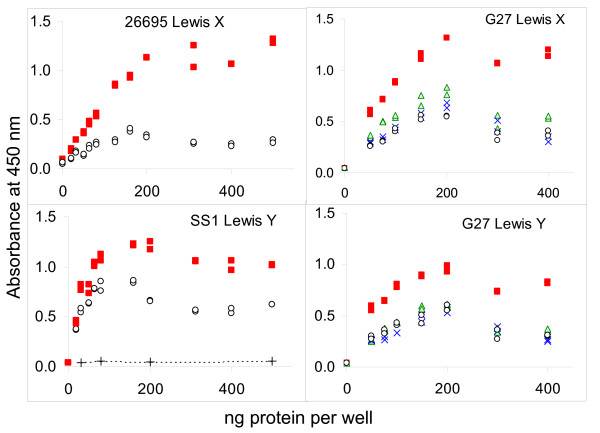
Growth in cholesterol specifically enhances cell surface display of Lewis antigens. Whole cell ELISA assays were performed on samples of H. pylori strain 26695 (upper left), SS1 (lower left), or G27 (upper and lower right). Parallel cultures were grown overnight in defined medium containing 130 μM of the following additions: circles, no addition; squares, cholesterol; triangles, β-sitosterol; X, taurocholate. Varying amounts of cell suspension corresponding to known amounts of cellular protein were applied to duplicate wells of ELISA plates, and immunoassayed for the presence of Lewis X or Lewis Y antigen as described in Methods. Negative control samples of E. coli HB101, or buffer-only blanks, fell on the dotted line. Absorbance readings for individual wells are plotted. Repeat experiments with three or more independently grown cultures have yielded essentially identical results.